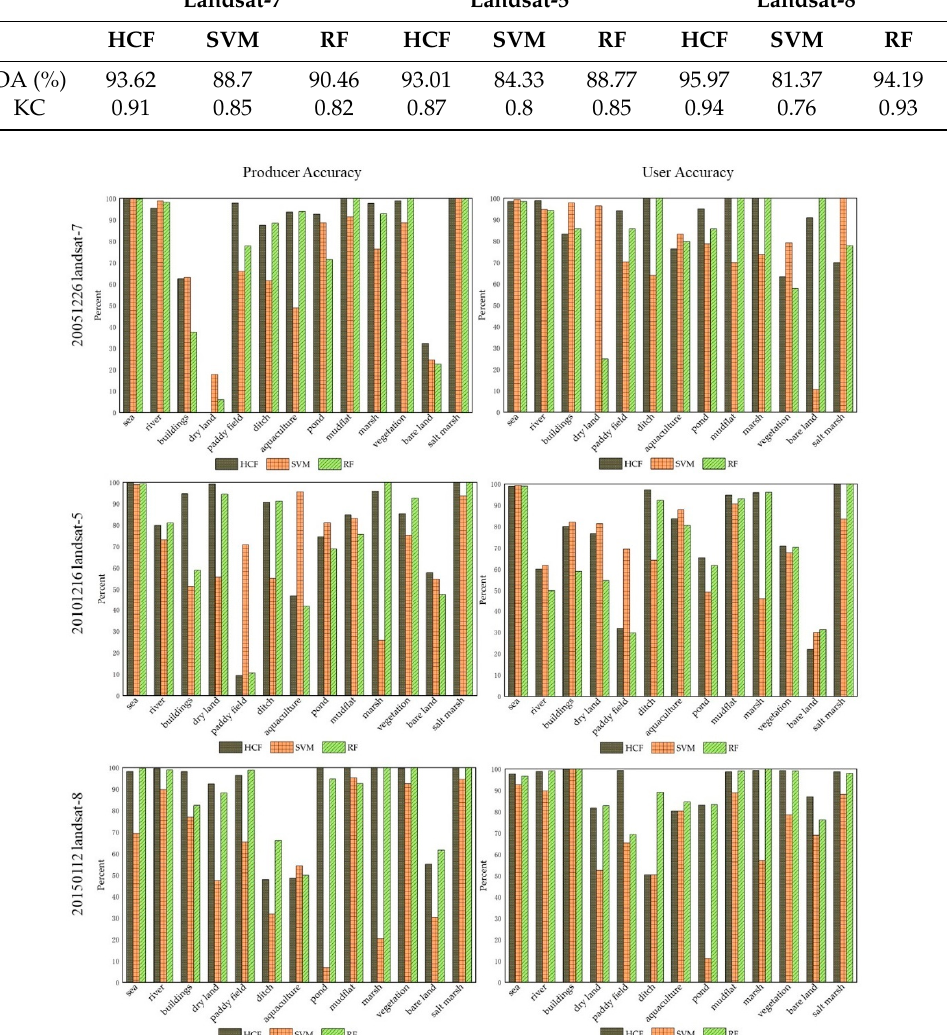
Figure 3. The comparison of producer’s accuracy (PA) and user’s overall (UA) between HCF, support vector machine (SVM) and random forest (RF) on Yellow River Estuary Landsat data. Table 4. Classification accuracies from HCF, SVM and RF on the Yellow river estuary Landsat data.